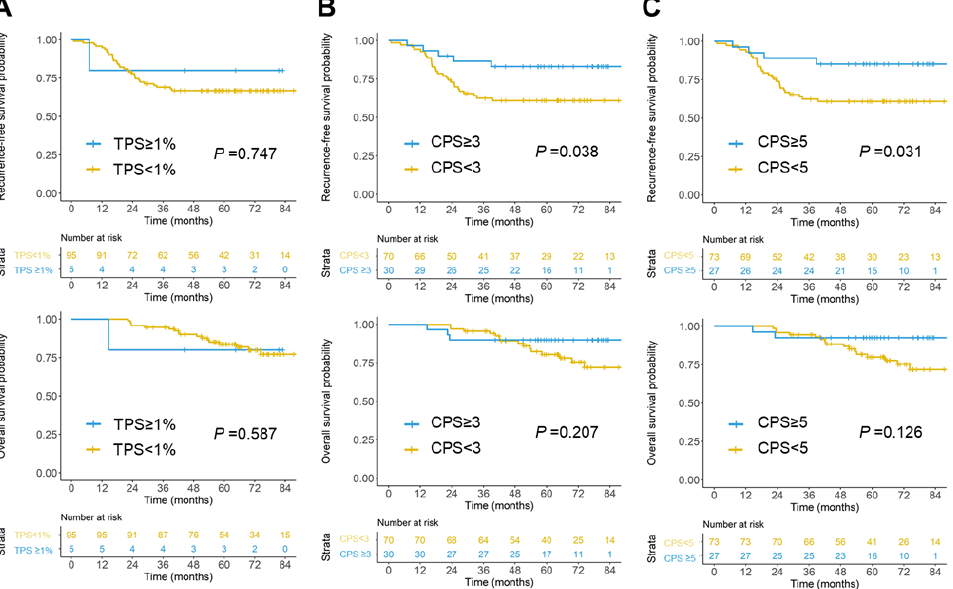
Figure 2. Survival difference of CRC patients at different cutoffs of PD-L1 expression levels. Kaplan – Meier analyses of recurrence-free survival and overall survival in CRC patients with high and low PD-L1 expression using a TPS cutoff value of 1 ( A ), CPS cutoff values of 3 ( B ), and 5 ( C ) are shown. RFS, recurrence-free survival; OS, overall survival; CI, 95% confidence interval.